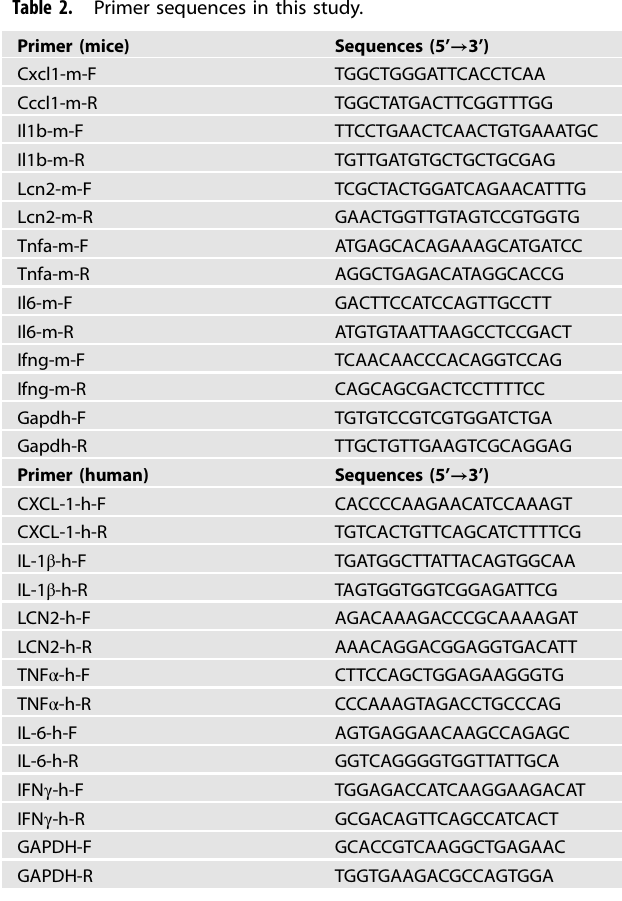
Table 2. Primer sequences in this